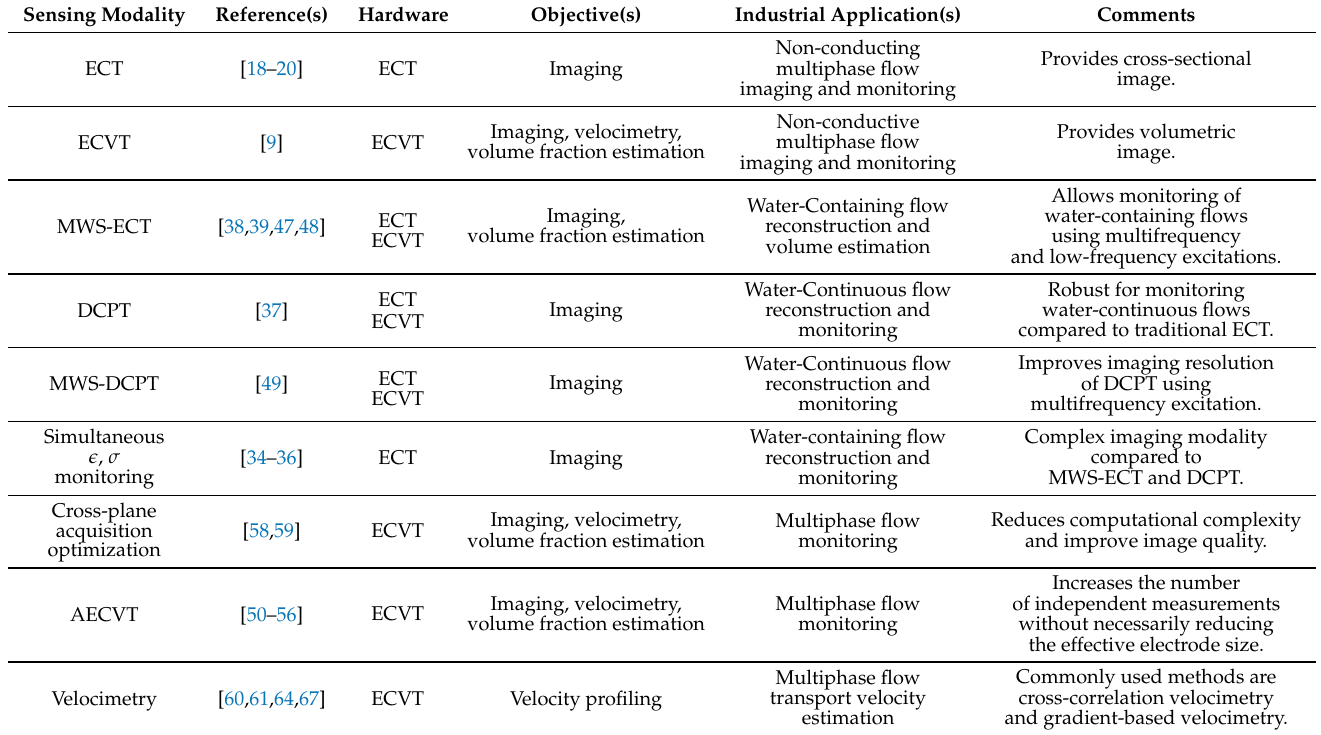
Table 1. Summary description of some selected recent developments in ECT-based and ECVT-based sensing